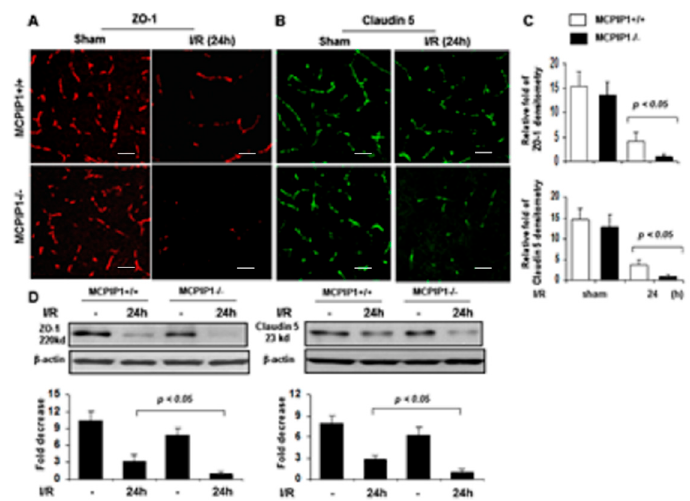
Figure 4. Altered expression of tight junction proteins zonula occludens-1 (ZO-1) and claudin-5 in the brains of MCPIP – / – mice subjected to transient focal ischemia / reperfusion. ( A , B ) Representative photomicrographs of immunofluorescence staining using AlexaFluor ® -conjugated secondary antibodies. The red fluorescence indicates expression of ZO-1 and the green fluorescence indicates expression of claudin-5 in brain sections of the MCPIP1 – / – mice and their wild-type littermates subjected to 2 h of MCAO followed by 24 h of reperfusion. The relative levels of ZO-1 and claudin-5, assessed by immunofluorescence intensity, are presented in bar graphs ( C ). Levels of ZO-1 and claudin-5 were significantly reduced in the MCPIP1 – / – mice compared to that seen in their wild-type littermates subjected to 24 h of reperfusion after 2 h of MCAO. Values represent mean ± SD. p < 0.05, n = 6 per group. ( D ) Protein extracts from the mice brains were subjected to immunoblot analysis with anti-ZO-1 or anti-claudin 5 antibodies, and β -actin served as a loading control ( Upper panels ). Bar graphs show the levels of ZO-1 ( Lower panel, left ) and claudin-5 ( Lower panel, right ), assessed by densitometric analysis normalized by β -actin protein levels and expressed as fold change compared the sham-operated animals. Levels of ZO-1 and claudin-5 in the brain of the MCPIP1 – / – mice were significantly reduced compared to that seen in their wild-type littermates subjected to 24 h of reperfusion after MCAO I / R hemisphere was measured by western blot with mixed samples of three independent experiments. Values represent mean ± SD. p < 0.05 between the MCPIP1 – / – mice and their wild-type littermates. n = 6 per group. Scale bar, 25 µm.